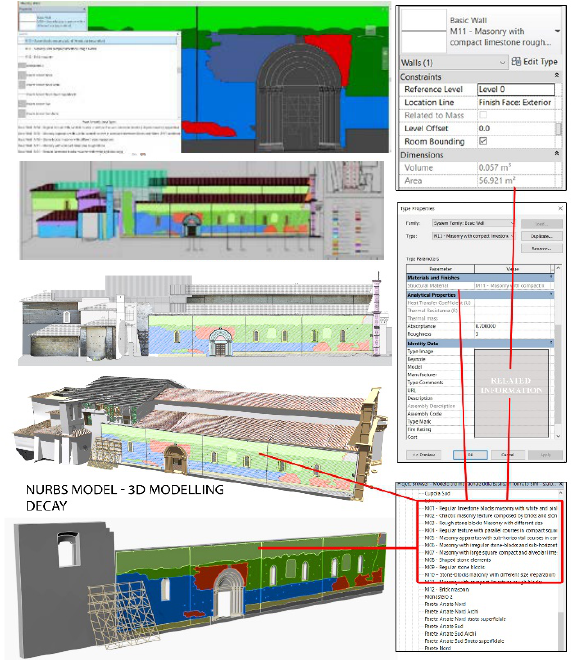
Figure 3. The example of the NURBS-based BIM modelling of the damaged north front with the Holy Door